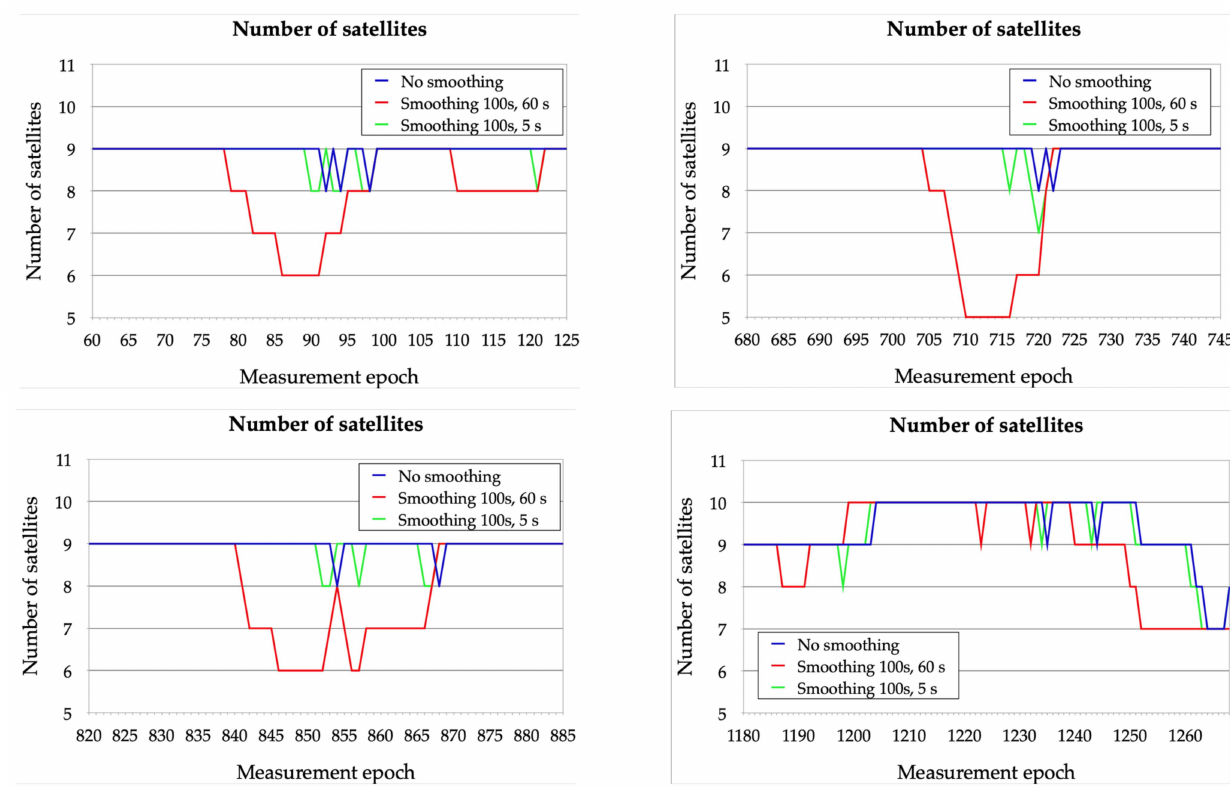
Figure 3. Selected sections showing the number of satellites used in positioning in the no smoothing, smoothing 100 s, 5 s, and smoothing 100 s, 60 s variants.